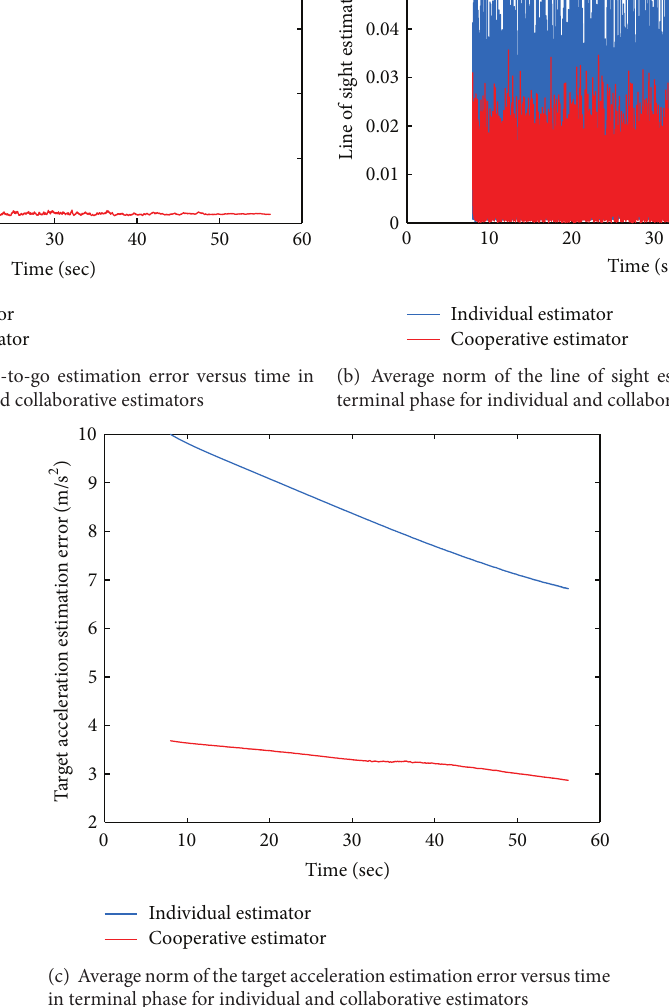
of multiple missiles intercepting a ballistic target.